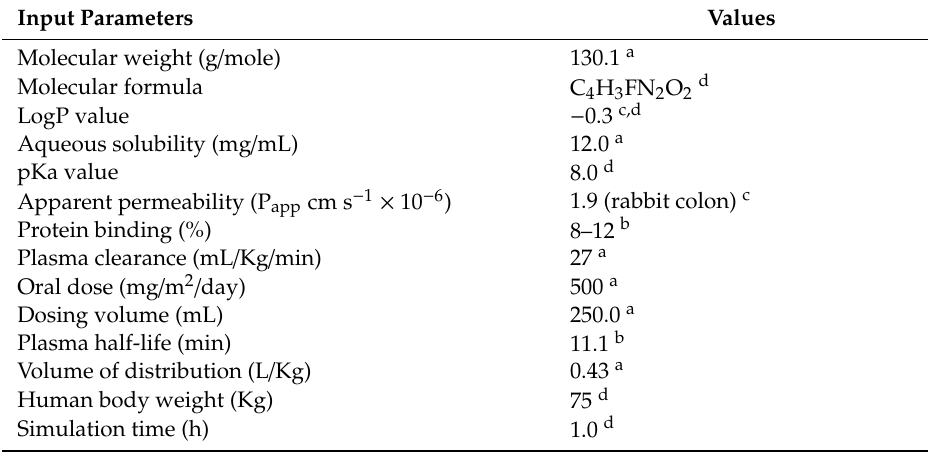
Table 3. Details of the input parameters for 5-FU in the ACAT model of the GastroPlus ®